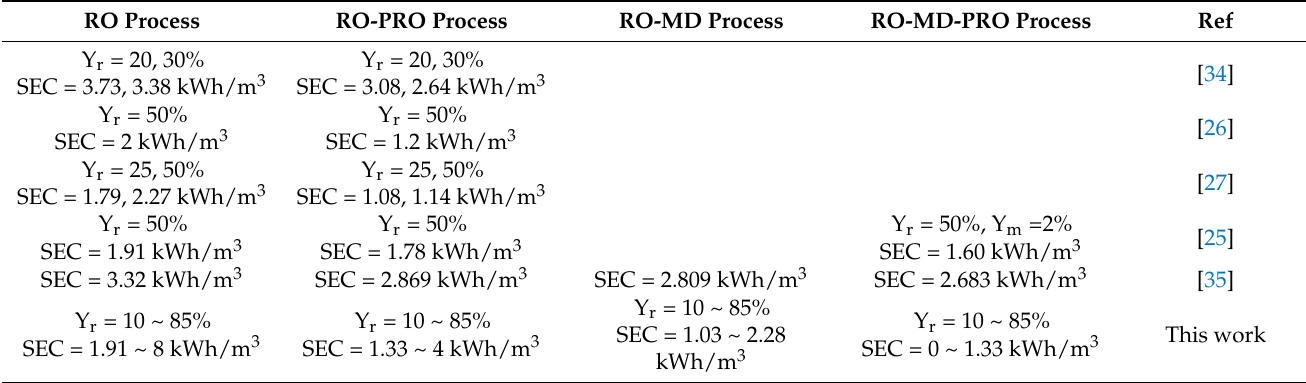
Table 3. SEC values from the literature and simulation results in this study. RO Process RO-PRO Process RO-MD Process RO-MD-PRO Process